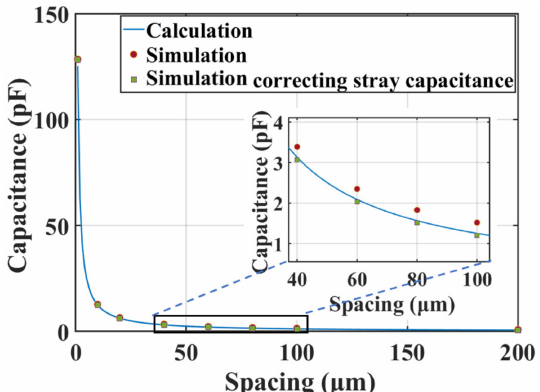
Figure 5. The calculation and simulation of the relationship between the measured capacitance and the spacing.